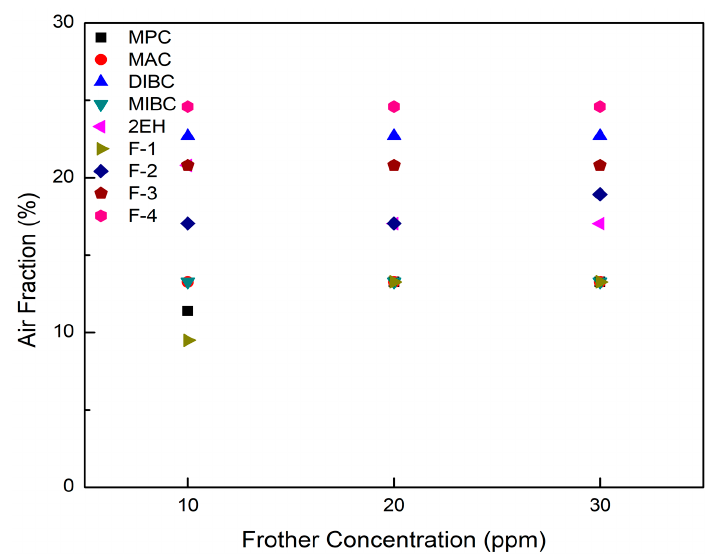
for each of the nine frother types.